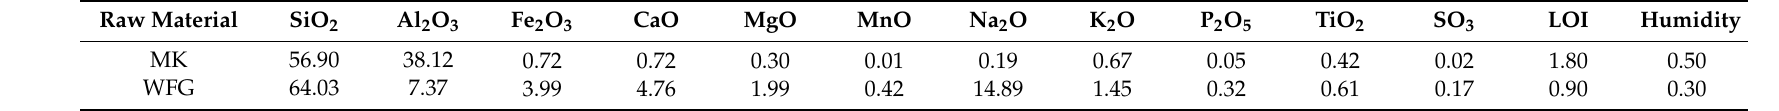
Table 1. Chemical composition (wt.%) of the raw materials (metakaolin (MK) and waste foam glass (WFG)). Raw